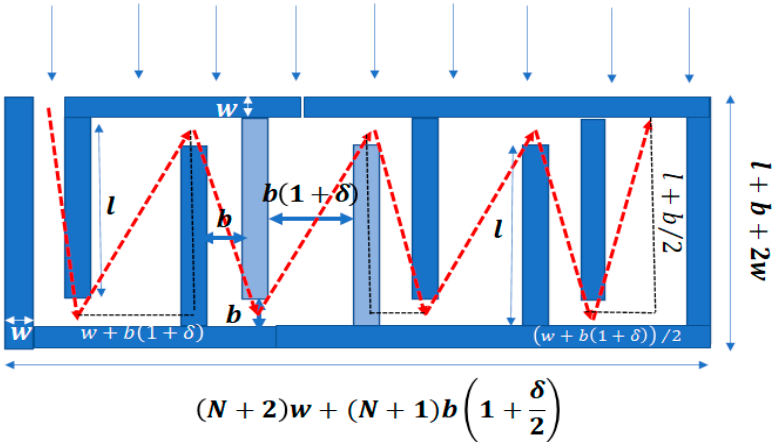
Figure 6. A vertical ‐ wall labyrinthine slit with alternating